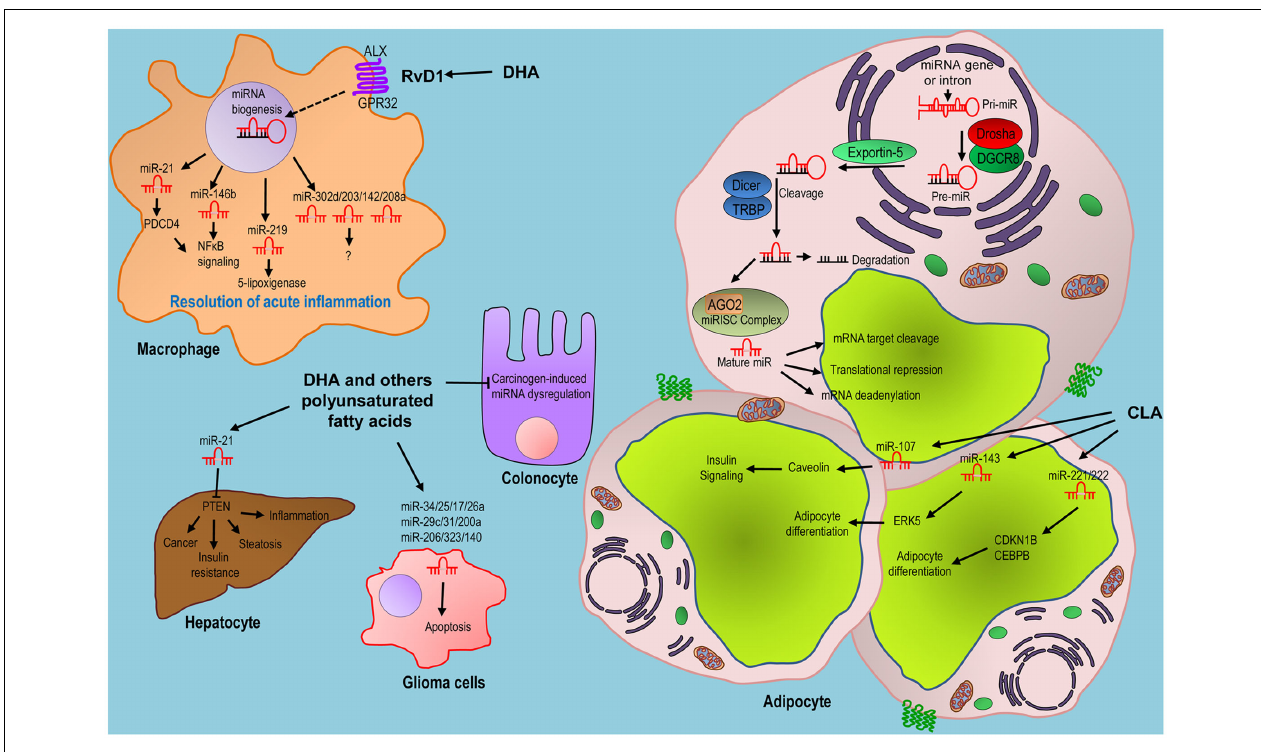
of different miRNAs in adipocytes, including miRNA-107, -143, -221, and miRNA-222 and postranscriptionally regulate the expression of different proteins involved in insulin signaling and adipocyte differentiation. DHA – through the resolving D1 (RvD1) pathway – may also modulate the resolution of acute inflammation. Resolvins are enzymatically synthesized from essential fatty acids, including DHA, during inflammation. Binding of RvD1 to its receptors ALX and/or GPR32 modulates the expression of different miRNAs that may be involved in this process. Different other studies propose that DHA and other polyunsaturated fatty acids modulate the expression of different miRNA in hepatocytes, glioblastoma or colon cancer cells related to different biological processes. miRNA-21 postranscriptionally regulates the tumor suppressor phosphatase and tensin homolog (PTEN) involved in different pathological